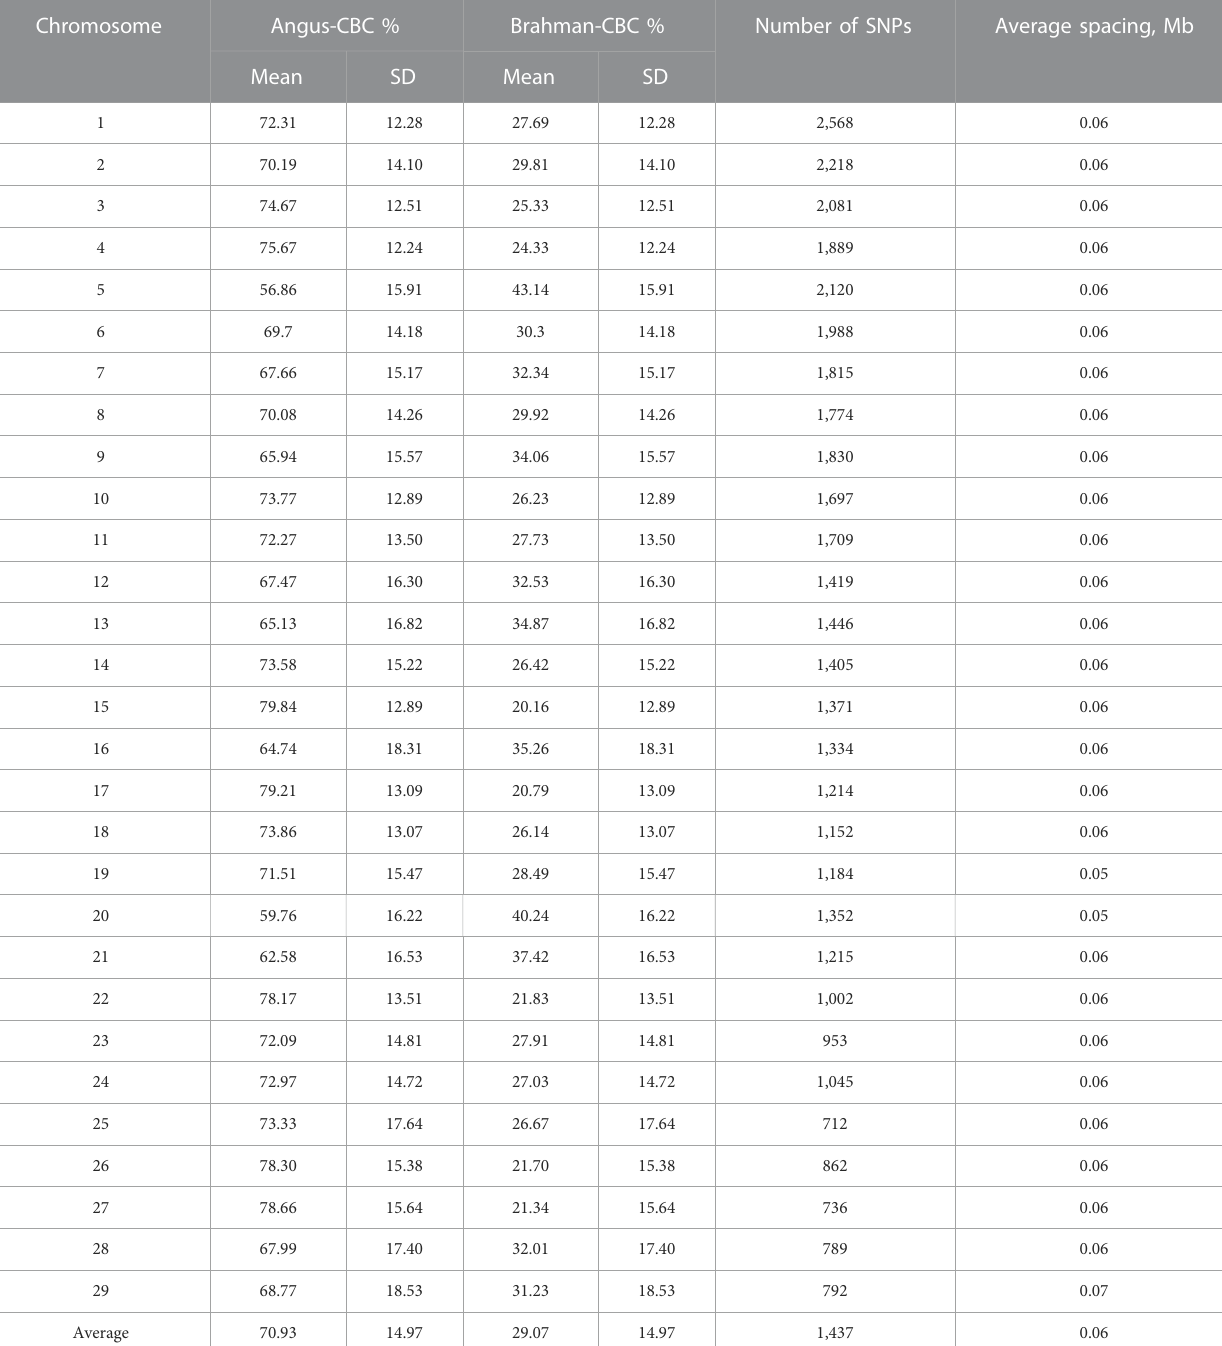
TABLE 4 Means and standard deviations (SD) of chromosomal-estimated breed compositions (CBC) for the 3,605 Brangus cattle. Chromosome Angus-CBC % Brahman-CBC % Number of